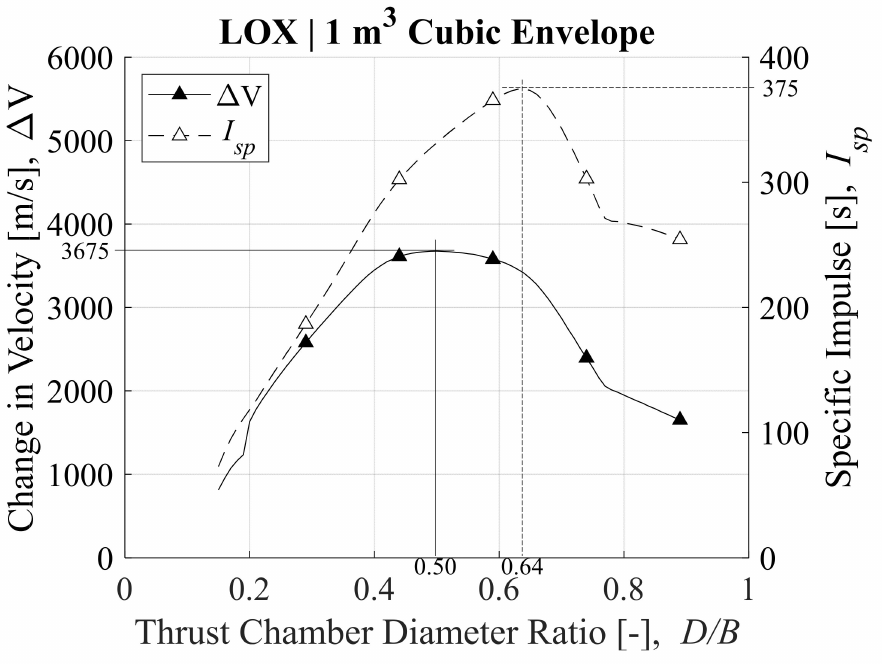
Figure 11. ∆ V is optimized with a smaller thrust chamber than that which optimizes I sp